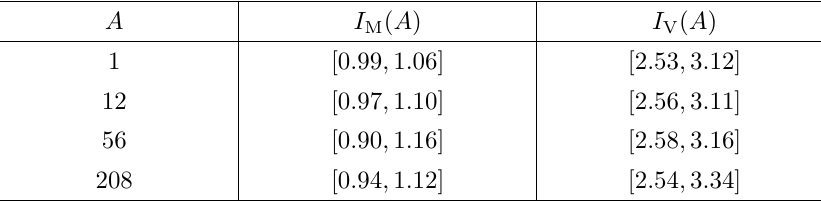
The 90% CL ranges for the momentum and valence integrals, eqs. (4.6) and (4.7), in the variants of the nNNPDF2.0 (cid:12)ts whether either one or the other sum rule is not